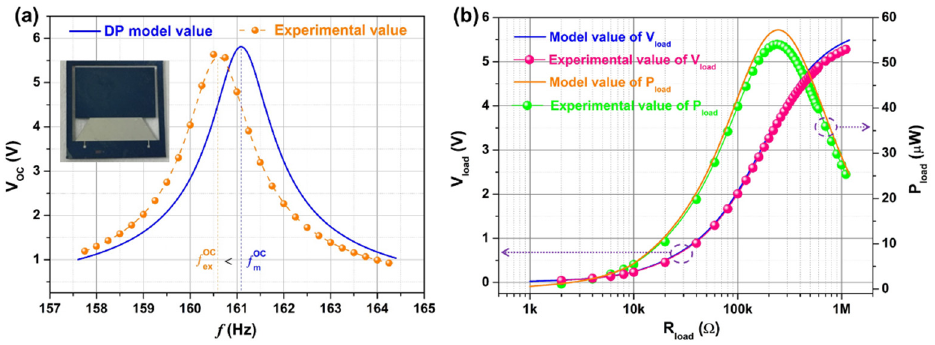
Figure 7. The open-circuit voltage frequency response curve ( a ) and the load output characteristic curve ( b ) of the MEMS TCB based PVEH prototype at the external excitation acceleration of 1 g.